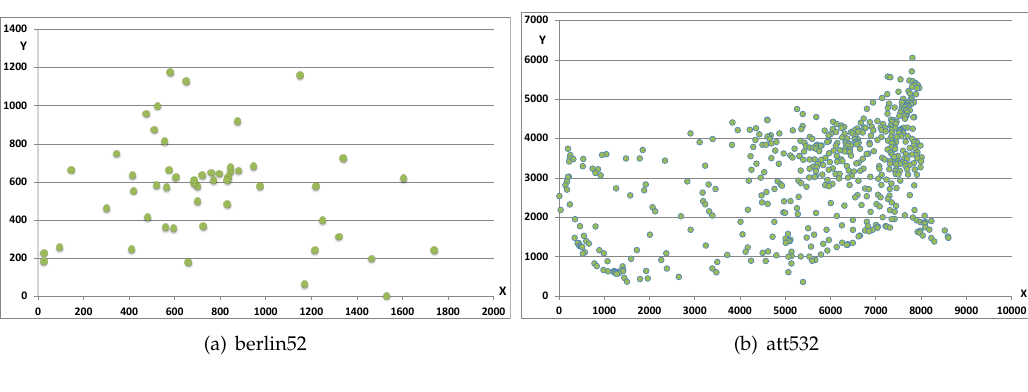
Figure 8. We use examples of two of TSP cities berlin52 and att532 to illustrate the regression-based technique for population initialization in GAs. The x − y scatter plots of ( a ) berlin52, and ( b )